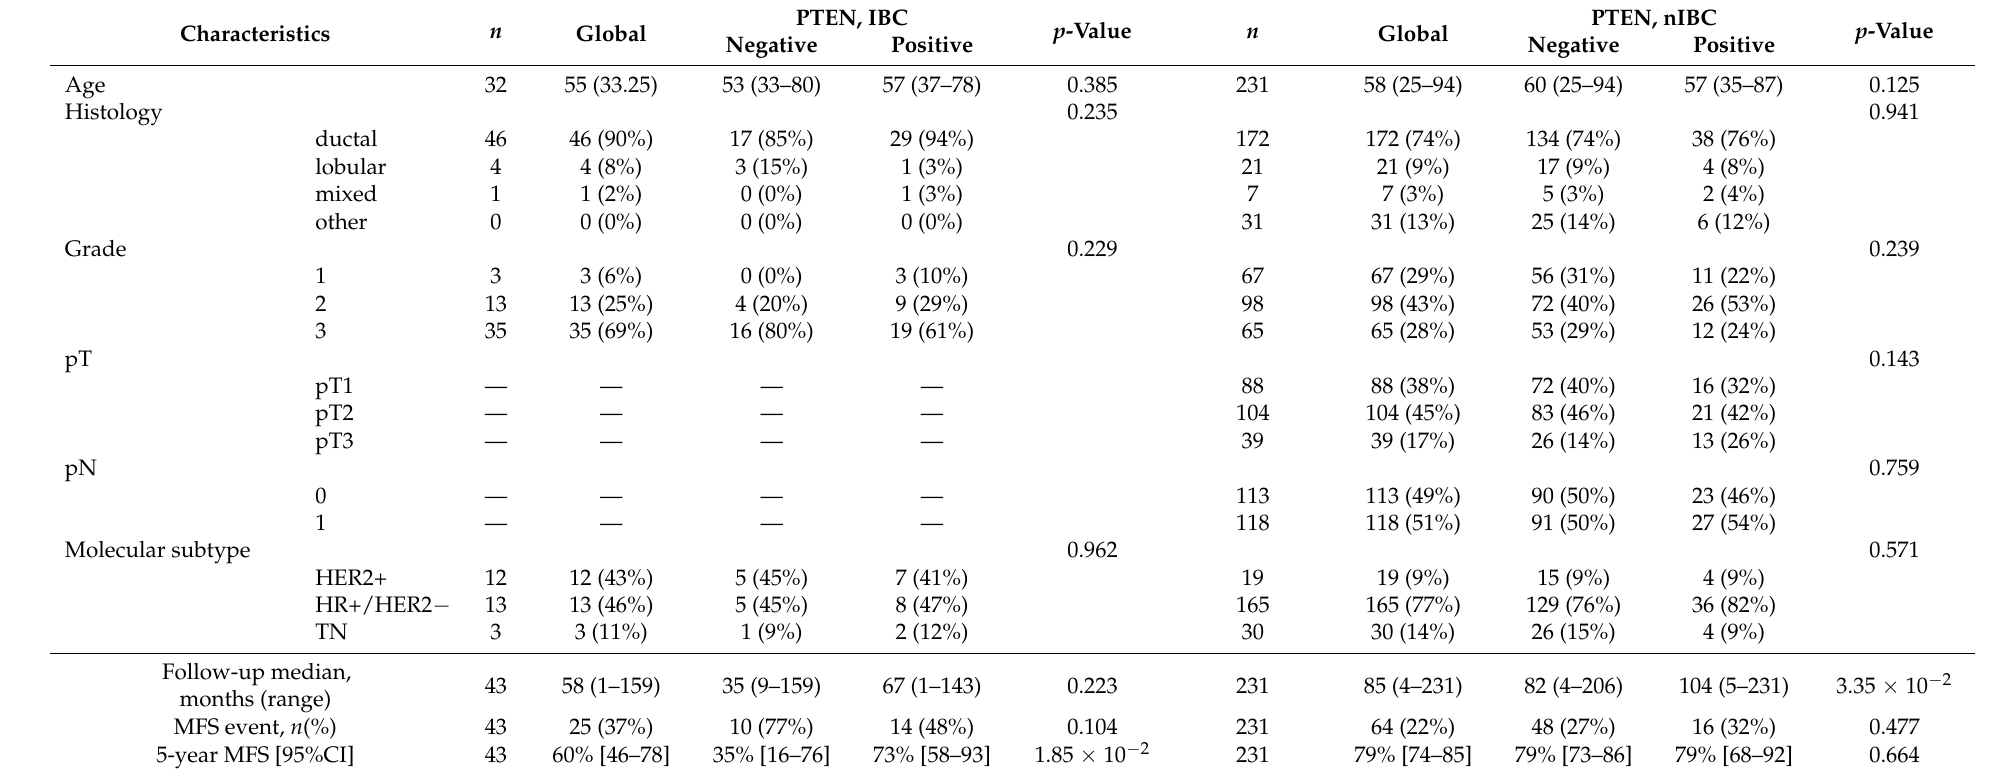
Table 2. Correlations of PTEN expression with clinicopathological variables in 54 IBC and 231